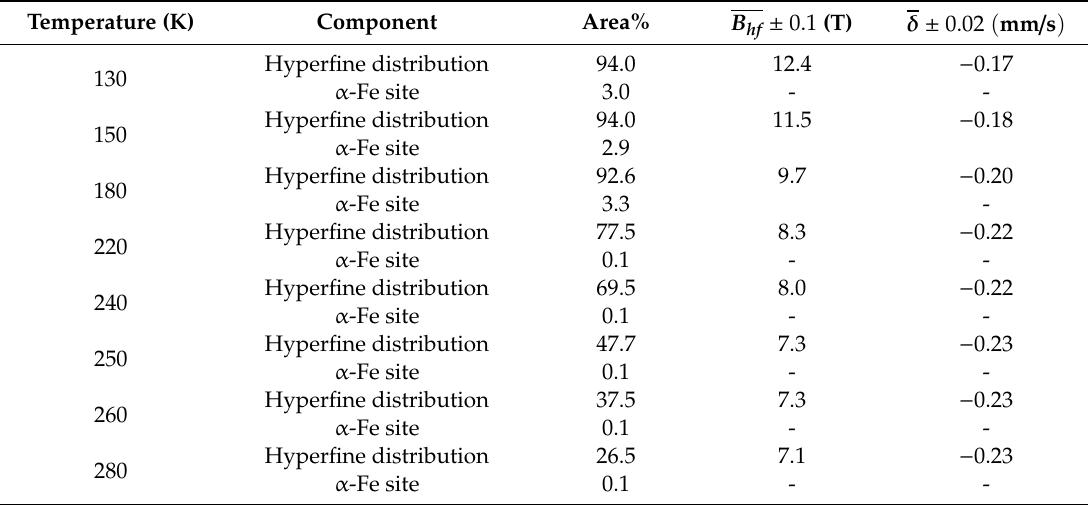
Table 1. Hyperfine parameters of the as-milled amorphous alloy after 50 h of milling. Area% is the relative contribution of the component, and B hf and δ are the mean values of the hyperfine magnetic field and the isomer shift of the distribution of hyperfine fields, respectively.